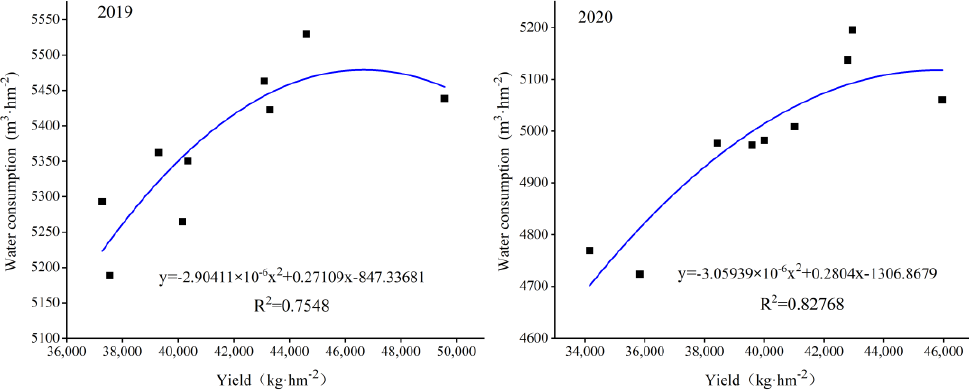
Figure 3. Relationship between potato yield and water consumption under drip irrigation and deficit regulation in the two growing seasons 2019 and 2020.